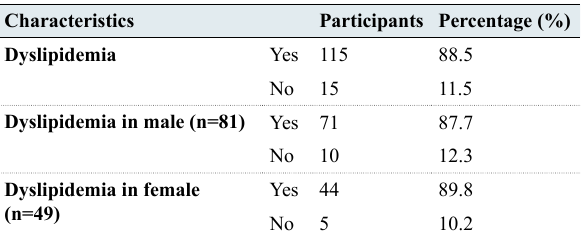
Table 1: Percentage of dyslipidemia in type 2 diabetes Mellitus patients